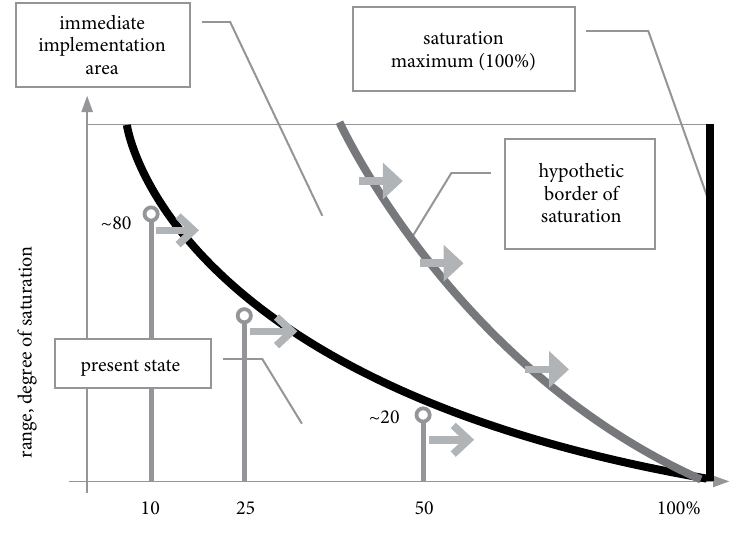
Fig. 6. Hypothetical saturation with IT